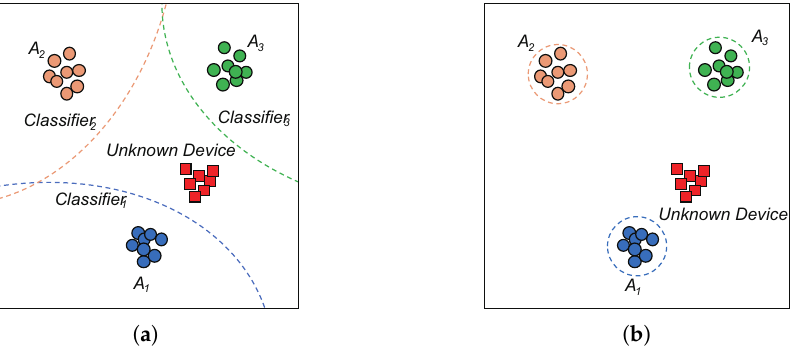
Figure 4. A demonstration of OvA and OpenMAX. Authorized devices are depicted as circles and unknown devices are depicted as squares. The dotted lines depict the boundaries of the classifiers. ( a ) Ova; ( b )